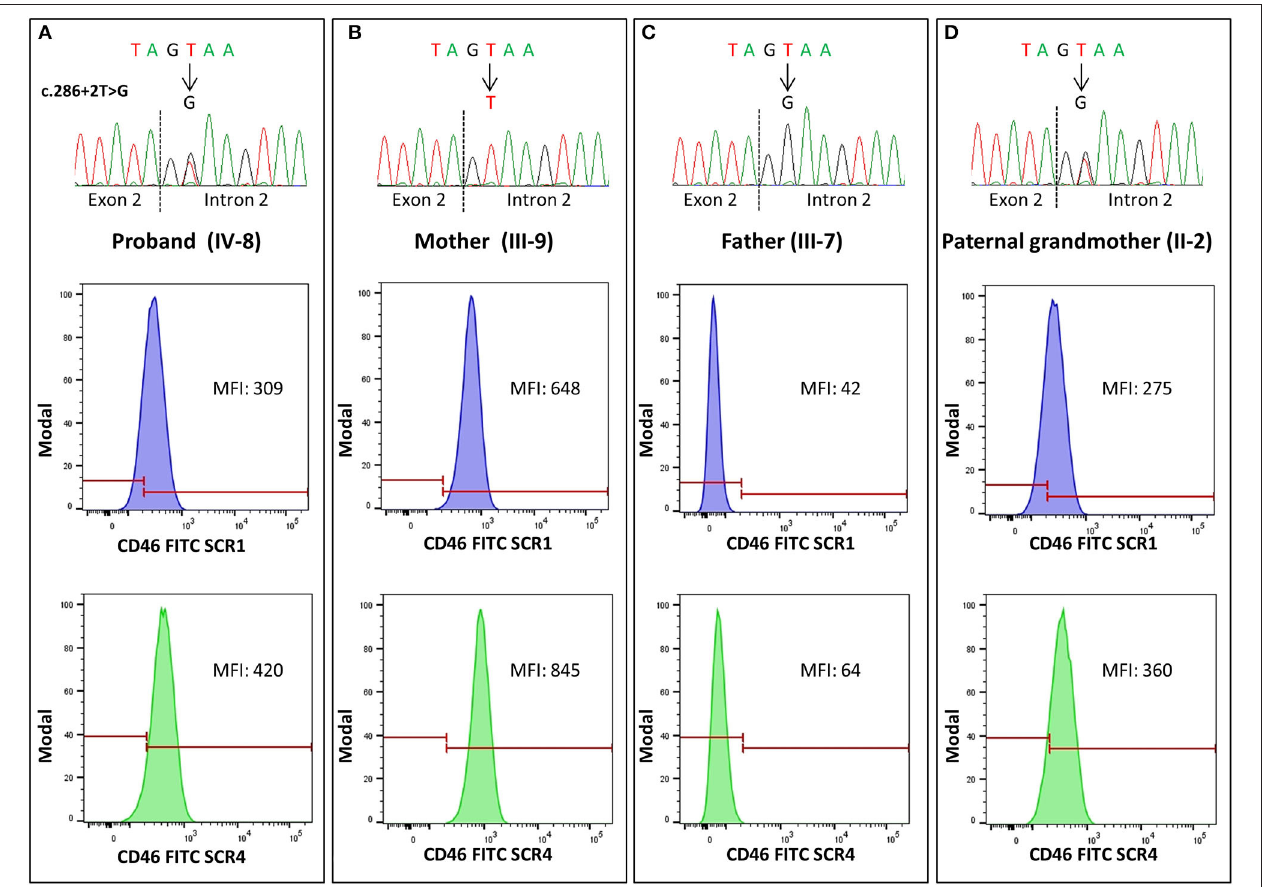
FIGURE 4 | Representative histograms of flow cytometry analysis in pedigree #646, performed with anti-SCR1 and anti-SCR4 antibodies showing levels of CD46 on CD3 + peripheral blood mononuclear cells (PBMCs), expressed as median fluorescence intensity (MFI). The heterozygous carriers of the 286 + 2T > G rare variant [the proband IV-8, (A) , and the paternal grandmother II-2, (D) ] showed about 50% CD46 expression compared with the wild-type mother [subject III-9, (B) ], while in the homozygous patient’s father [subject III-7, (C) ], a severe reduction of CD46 expression ( < 8% compared with the wild-type mother) was observed. The electropherograms of DNA sequences in the proband and his relatives are shown on the top of each panel.